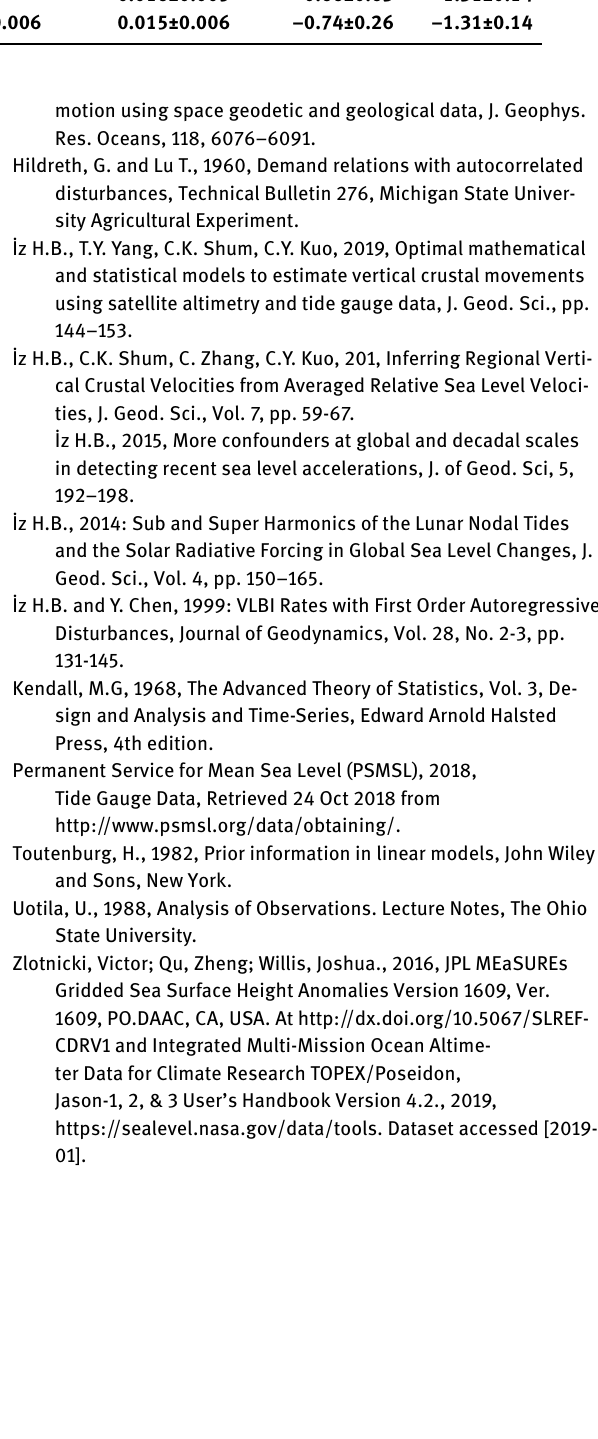
Table 2. Estimated trends and acceleration. N/S: Not Significant at 95% CL. SE of the estimates are 1 σ . Parameter